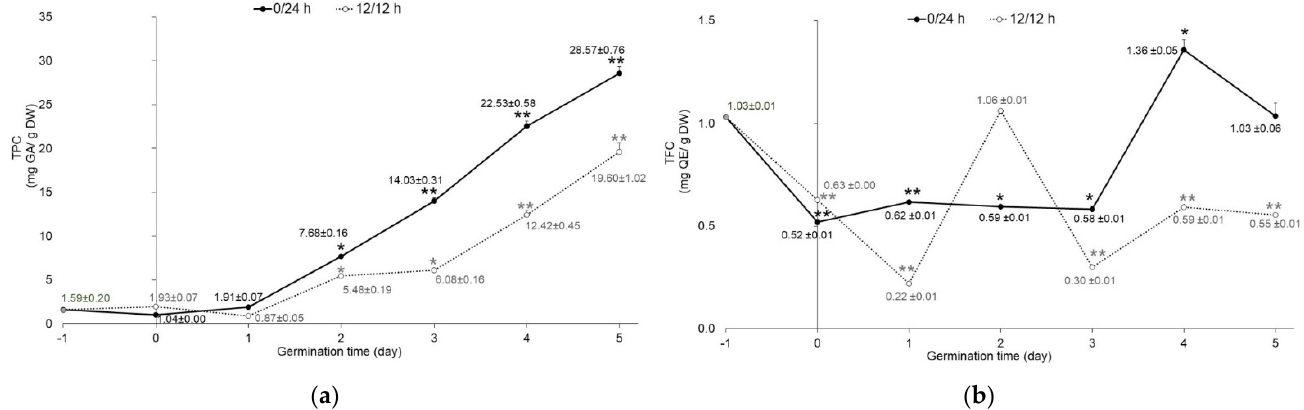
Figure 3. Content of ( a ) Total phenolic content (TPC) and ( b ) (TFC) total flavonoid content (TFC) of mung beans germinated in complete darkness (0/24 h; black line) and illumination (12 h/12 h; dotted line) from day 0 to day 5. Data of day − 1 represent raw material of mung seeds ( n = 3). Error bar represents SD; * p < 0.05, ** p < 0.001.